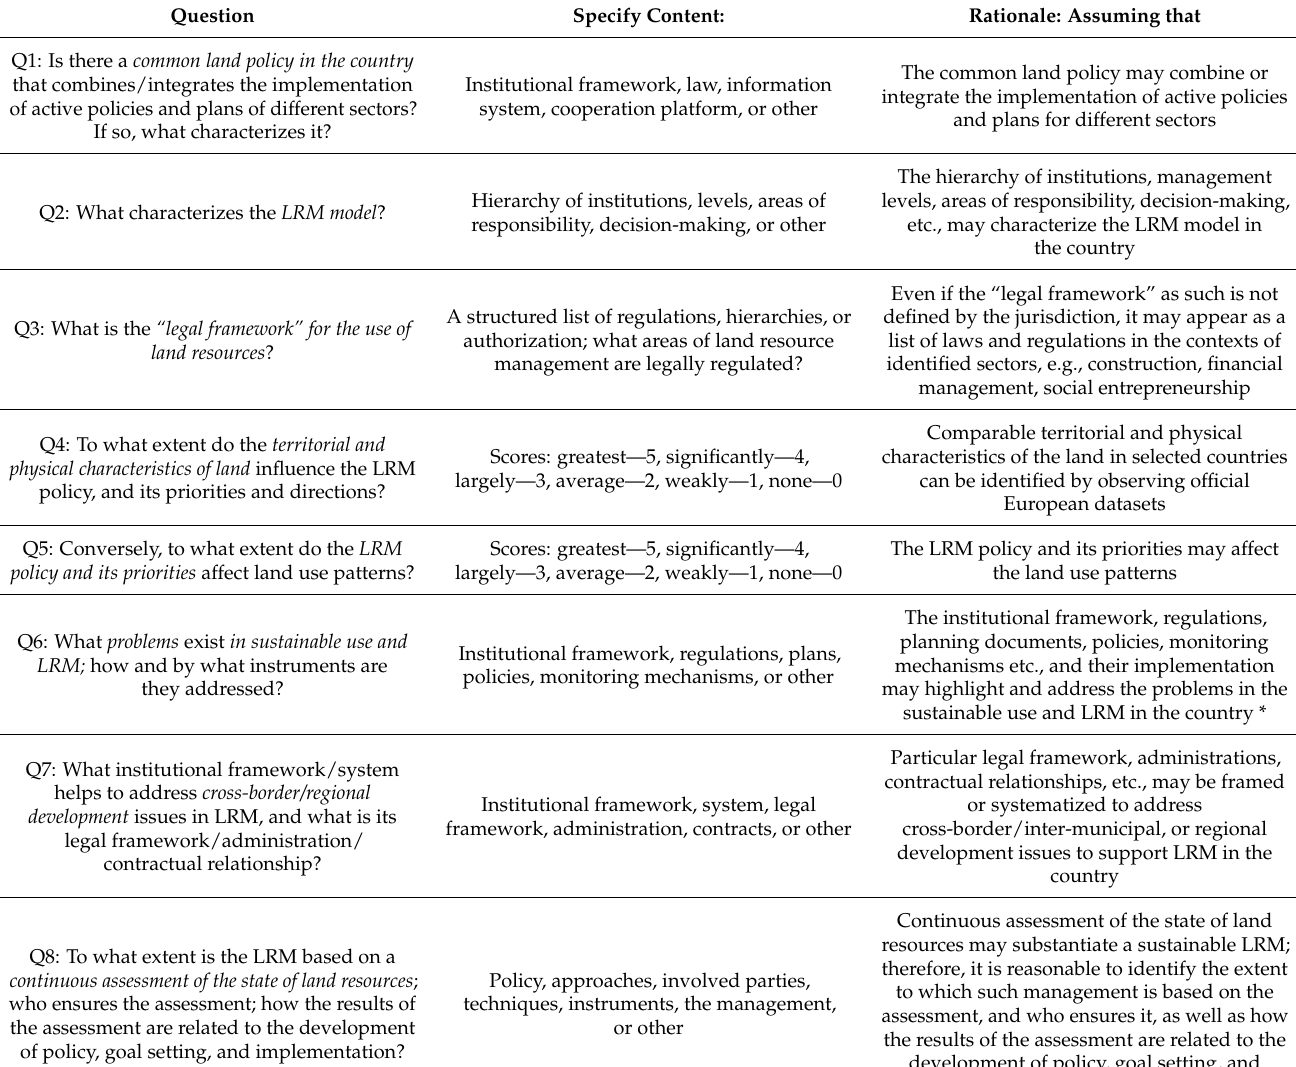
Table 1. Questionnaire of the comparative